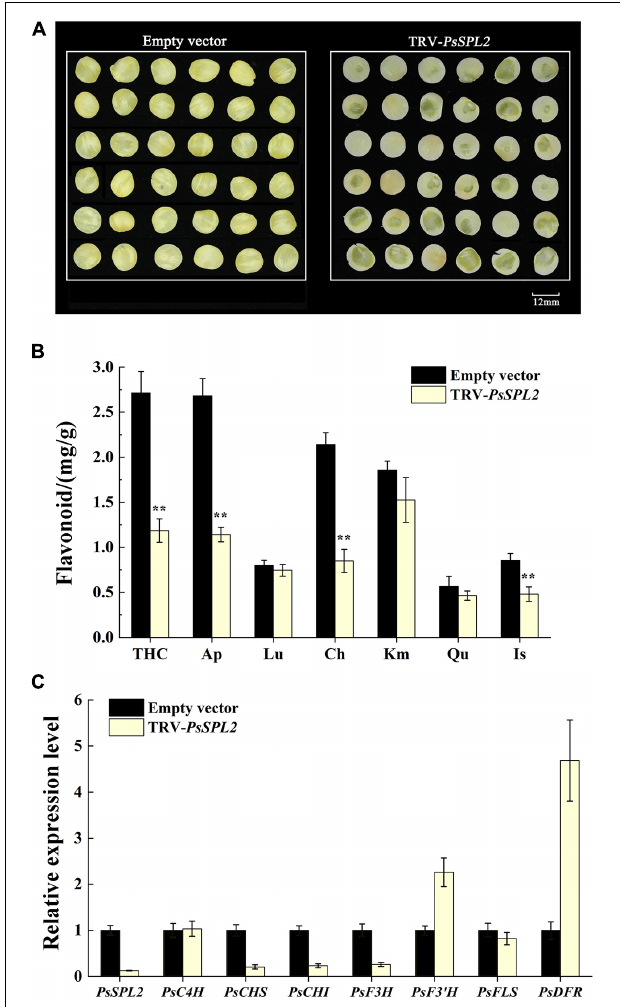
FIGURE 8 | Silencing of PsSPL2 by virus-induced gene silencing (VIGS) in petal discs of “High Noon.” (A) The phenotypes of the petal discs with Agrobacterium bearing a TRV empty vector and TRV- PsSPL2 , respectively. (B) Flavonoid contents in petal discs with Agrobacterium bearing a TRV empty vector and TRV- PsSPL2 , respectively. (C) The relative expression levels of PsSPL2 and corresponding structural genes by quantitative RT-PCR in petal discs with Agrobacterium bearing a TRV empty vector and TRV- PsSPL2 , respectively. Error bars represent standard error of the mean from three biological replicates. ** P <